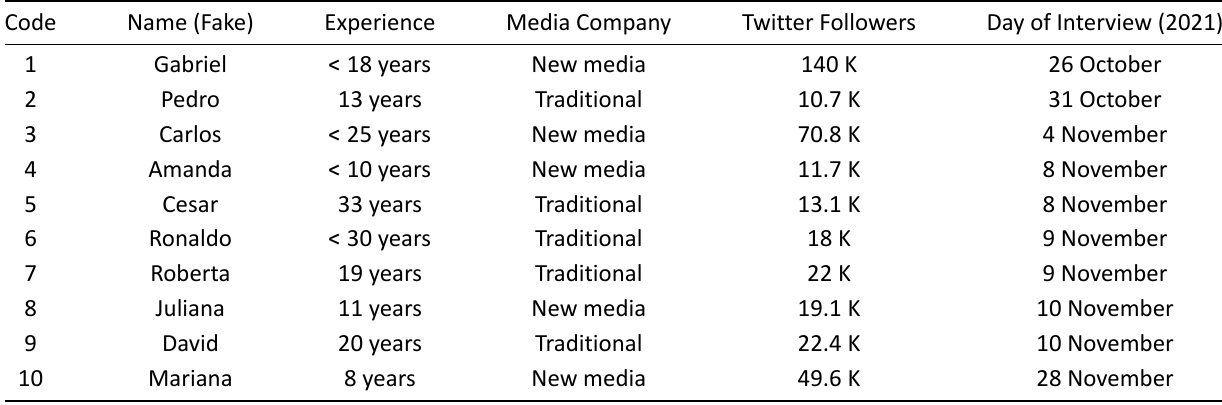
Table 1. Sampling